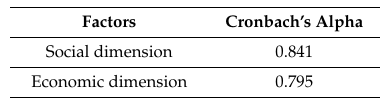
Table 6. Reliability of Host organization sustainability factors.